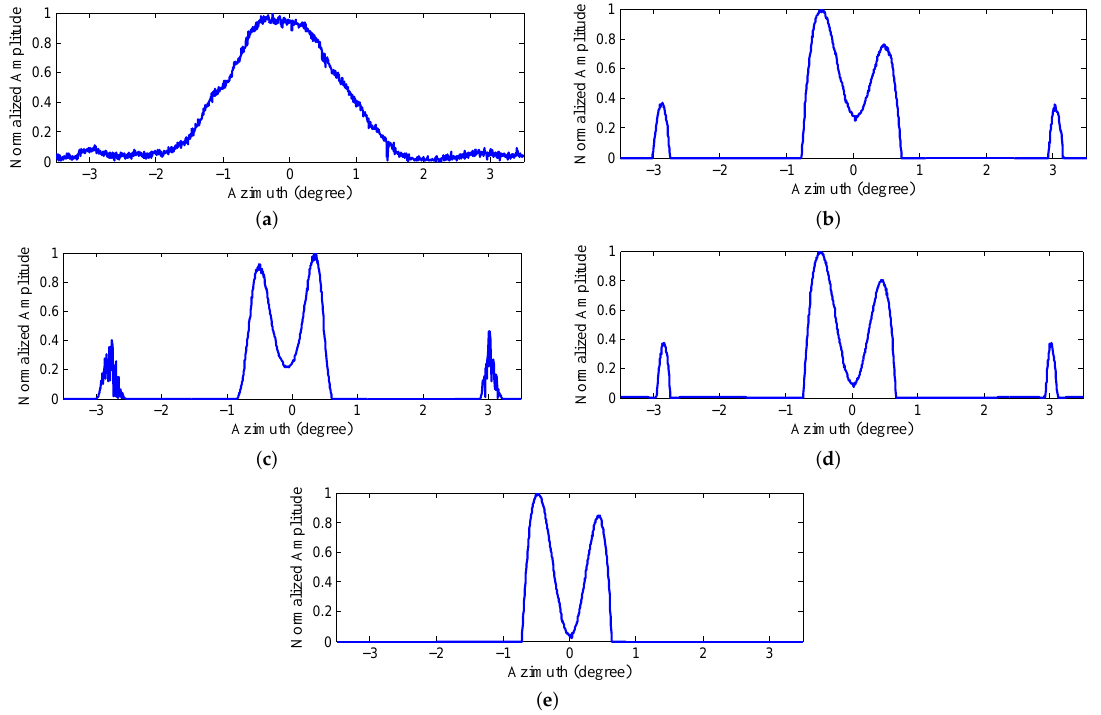
Figure 12. The profiles of the farthest corner reflectors in Figure 11 obtained by ( a ) real beam echo after range compression and migration correction ( b ) Landweber ( c ) Richardson-Lucy (RL) ( d ) maximum a posterior (MAP) ( e ) proposed penalized maximum likelihood